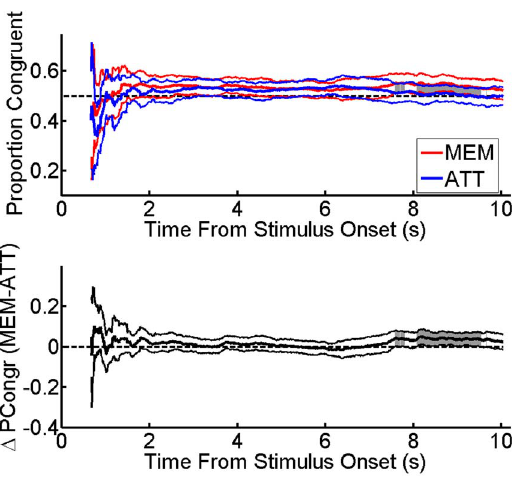
Figure 4. Time-course of dominance. Upper panel : average probability of seeing the ambiguous stimulus moving in the same direction as the unambiguous stimulus, expressed as a function of time from the ambiguous stimulus onset. Results are plotted only for time points at which more than 50% of observers provided data. Red : WM condition. Blue : attention condition. Lower panel : the same results are depicted as the difference in instantaneous probability between the WM and the attention condition. Thick and thin lines represent group averages and 95% confidence intervals respectively. Grey insets indicate the time points where the tendency to perceive the congruent motion direction was higher in the WM condition, as evidenced by paired- sample two-tailed t-tests conducted at each time-point on the trial timeline. are illustrated in Figure 5: whereas the probability of switching from a congruent to an incongruent percept was comparable in the two experimental conditions ( t (25)= 0.78, p =.44), switching from an incongruent to a congruent percept was significantly more likely in the WM than in the attention condition ( t (25)= 2.05, p , .05). This result points to a sustained influence of WM contents on perception over time.